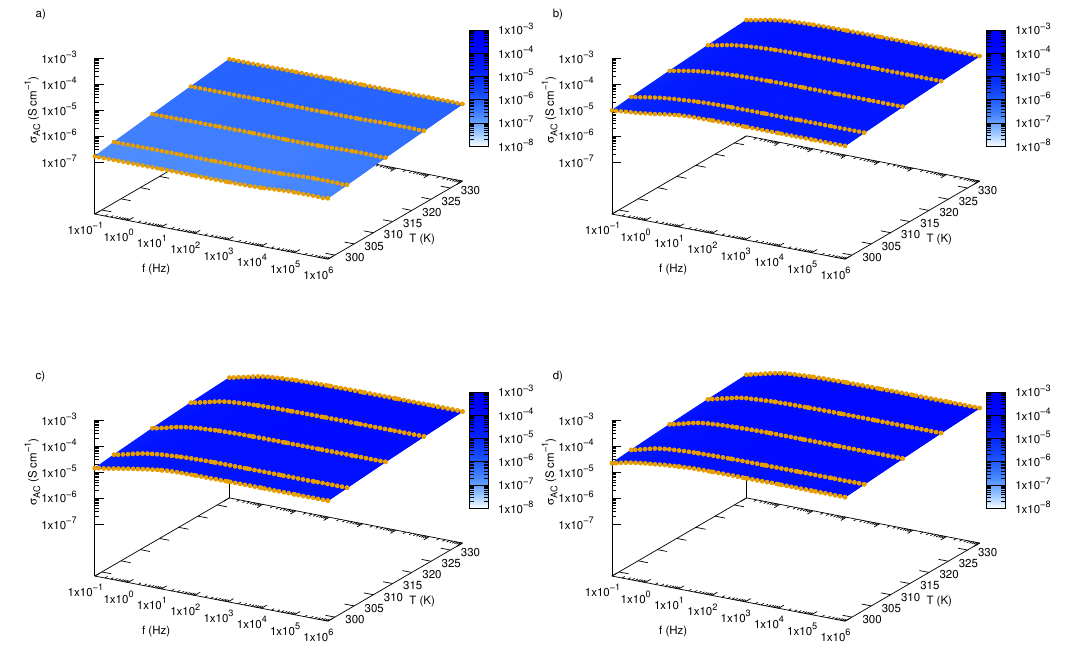
Figure 13. Electrical conductivity of silicon oxide lignin ethylene glycol nanofluids as function of frequency and temperature for ( a ) pure ethylene glycol, ( b ) 0.01 mass fraction, ( c ) 0.02 mass fraction, ( d ) 0.03 mass fraction.